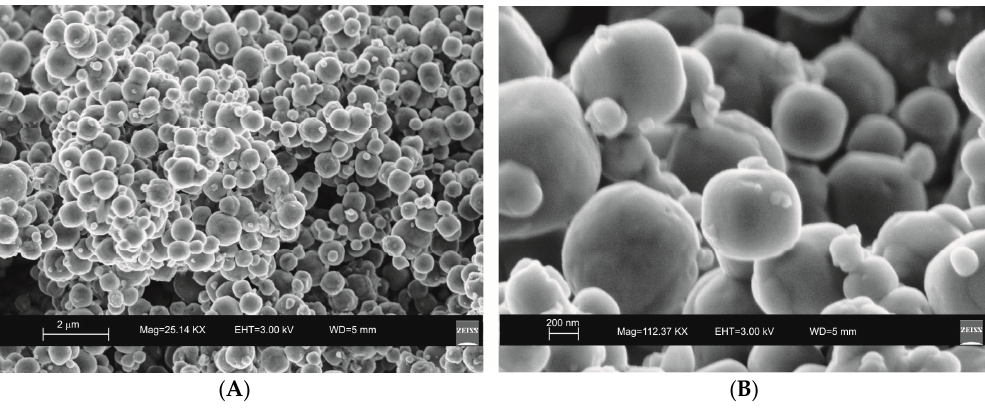
Figure 6. SEM images of LTA zeolite characterizing the sample 12 months after the conventional hydrothermal treatment. ( A ) overview of zeolites formed; ( B ) zoom in on LTA crystals.